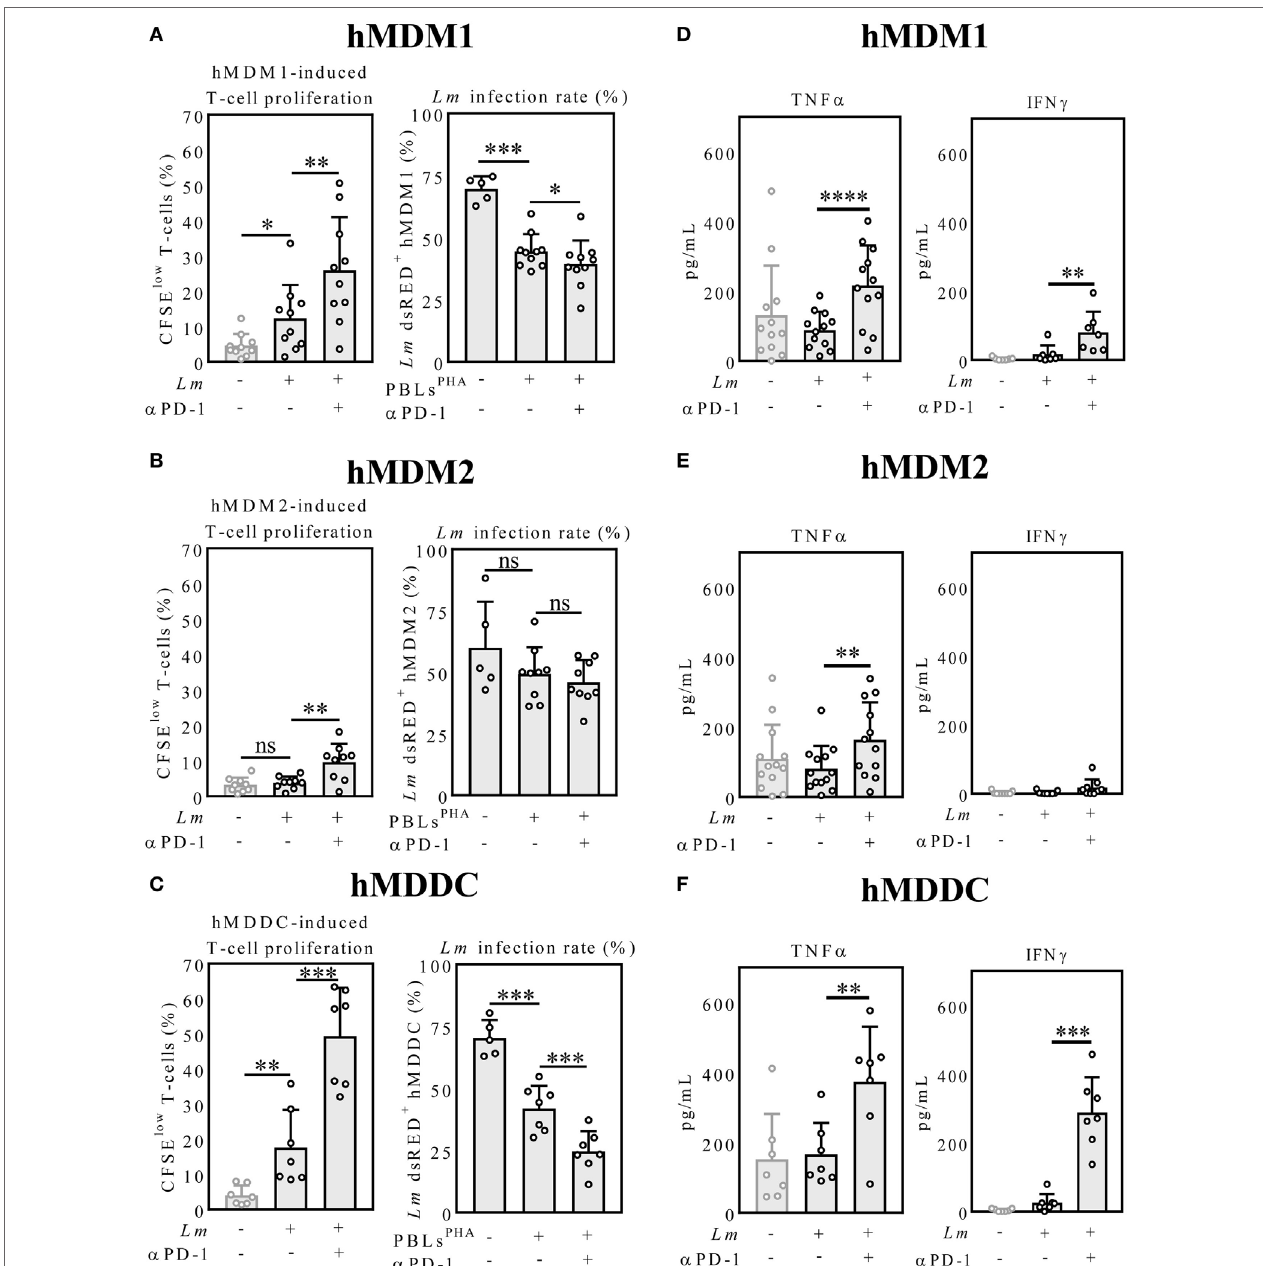
FigUre 2 | Host cell phenotype-dependent T-cell proliferation, parasite killing and cytokine release upon PD-1 blockade. (a–c) CFSE-labeled autologous PBLs PHA were cocultivated with Lm -infected host cells and blocked with nivolumab ( α PD-1). After 5 days, cells were harvested and analyzed by flow cytometry (hMDM/ hMDDC gated via their FSC/SSC properties, T-cells additionally via CD3). Data are presented as mean percentage of CFSE low proliferating T-cells ± SD or Lm dsRED-infected hMDDC ± SD, respectively. (D–F) IFN γ and TNF α were measured in the coculture supernatants by ELISA as described. Data are presented as mean pg/mL ± SD. For statistics, a parametric paired t -test was performed, P < 0.05 is considered statistically significant (* P < 0.05, ** P < 0.01, *** P < 0.001, **** P < 0.0001). At least three independent experiments were performed ( N = 5–13). hMDM1, proinflammatory human monocyte-derived macrophages type 1; hMDM2: anti-inflammatory human monocyte-derived macrophages type 2; hMDDC, human monocyte-derived dendritic cells; Lm , Leishmania major ;